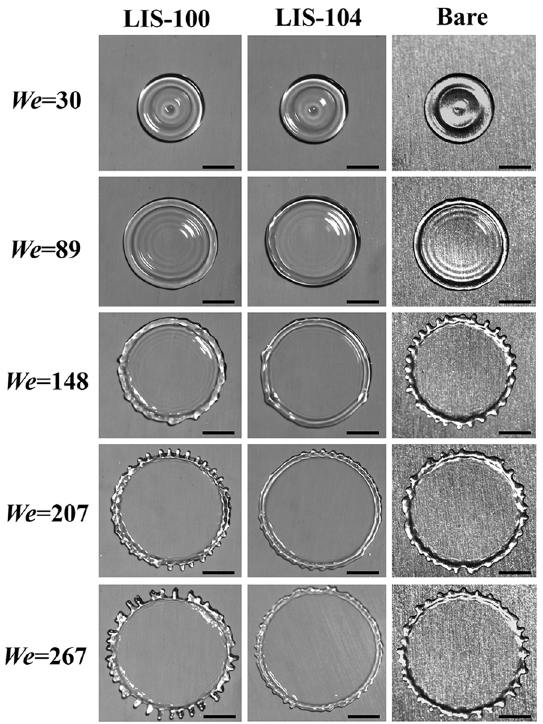
Figure 5. High-speed images of maximum spreading diameter of water droplets on bare, LIS-100 and LIS-104 surfaces at different We numbers; scale bar is 2 mm.